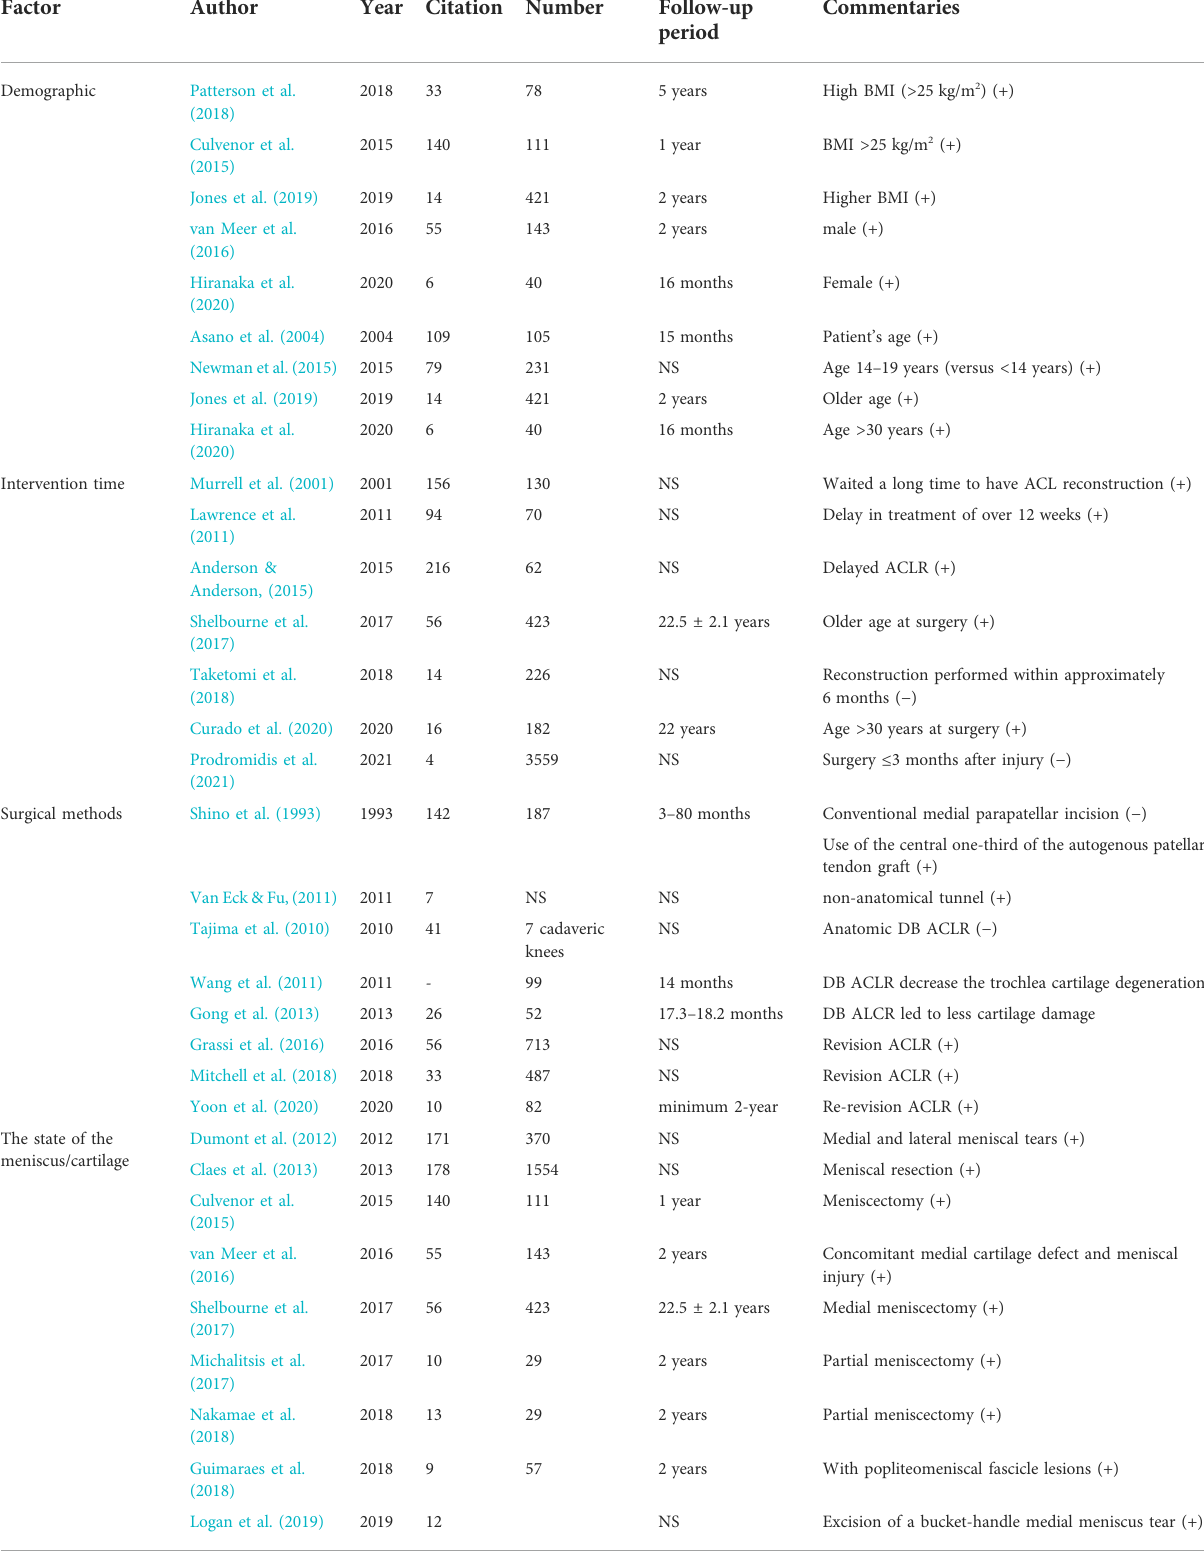
TABLE 1 Risk factors of Cartilage lesion after anterior cruciate ligament